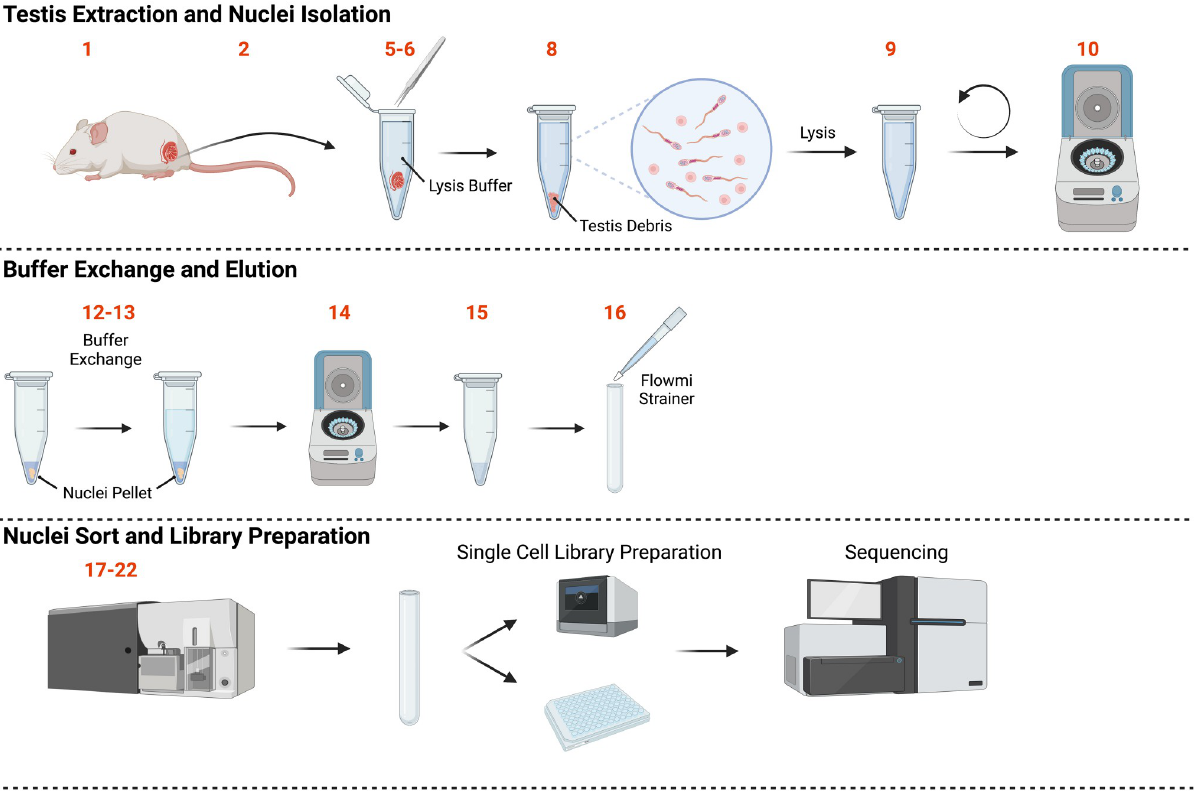
Fig 1. Schematic summary of the protocol. The protocol workflow consists of three key parts: 1) tissue collection, 2) nuclei isolation and buffer exchange, and 3) cell sorting. This protocol results in the isolation of haploid sperm-derived nuclei which may then be utilised in a variety of downstream applications, including both plate- and droplet-based